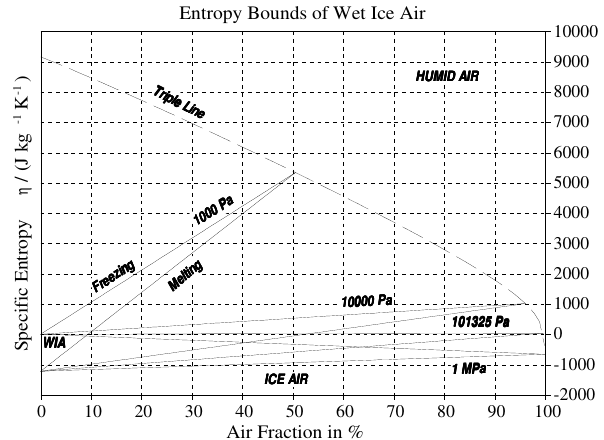
Fig. 12 Valid entropy values of wet ice air, “WIA”, computed from Eq. (S28.8) are restricted to narrow wedge-shaped regions depending on the air fraction w A between 0 and 100% for selected pressures P as shown. Only points ( w A , η ) selected from these regions permit valid solutions of case 5 discussed in Appendix A.12. At the upper entropy bound of wet ice air, wet air starts freezing, indicated as “Freezing” on the 1000 Pa case in the diagram. At the lower entropy bound of wet ice air, ice air starts melting, indicated as “Melting”. The locus of the wedge tips at various pressures is the triple line, shown dashed, at which ice, liquid water and water vapour coexist in the presence of air, Eq. (S28.8). Freezing and melting curves were computed with the library functions ice_liq_meltingtemperature_si in conjunction with ice_air_g_entropy_si and liq_air_g_entropy_si. For running w A , the triple line is computed by calling the sequence set_liq_ice_air_eq_at_a , liq_ice_air_temperature_si , liq_ice_air_pressure_si and air_g_entropy_si. Fig. 11 corresponds to case 1 in the Appendix A.12 with fixed dry air fraction, A . It illustrates that the temperature of wet ice air differs only very little from the triple-point temperature of water, almost independent of pressure, causing the adiabatic lapse rate under these conditions to be very small. Note that the curve shown here neglects the solubility of air in water which could result in temperature effects of similar order. Fig. 12 shows results corresponding to case 5 from Appendix A.12 in which the dry-air fraction, w A , entropy, η , and the liquid fraction of the condensed part, w = w W / ( w W + w Ih ) are specified. If an air parcel is lifted with the first two quantities fixed , then w varies between 0 at the melting level (completely frozen condensate), and 1 at the freezing level (completely molten condensate). Four valid wedge-shaped Wet-Ice-Air (WIA) regions are shown in this